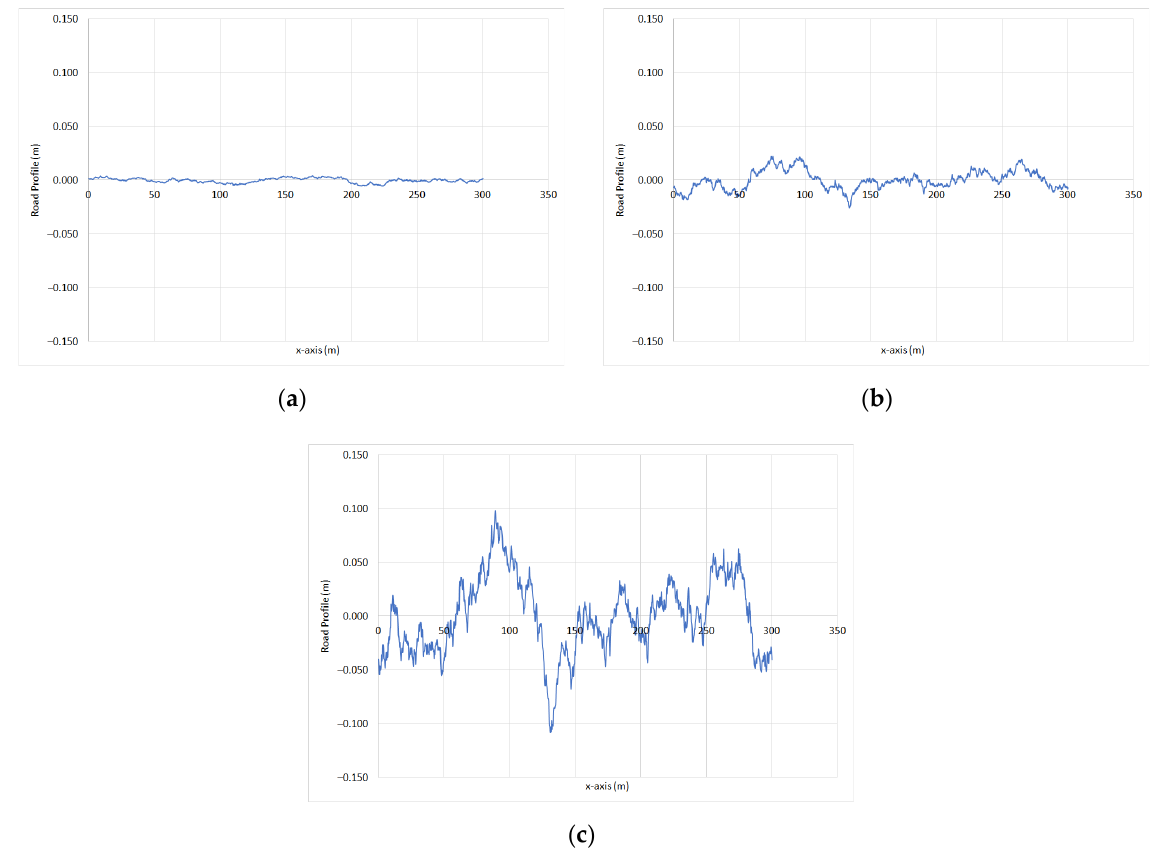
Figure 8. The road profile of ( a ) Class A, ( b ) Class C and ( c ) Class E.